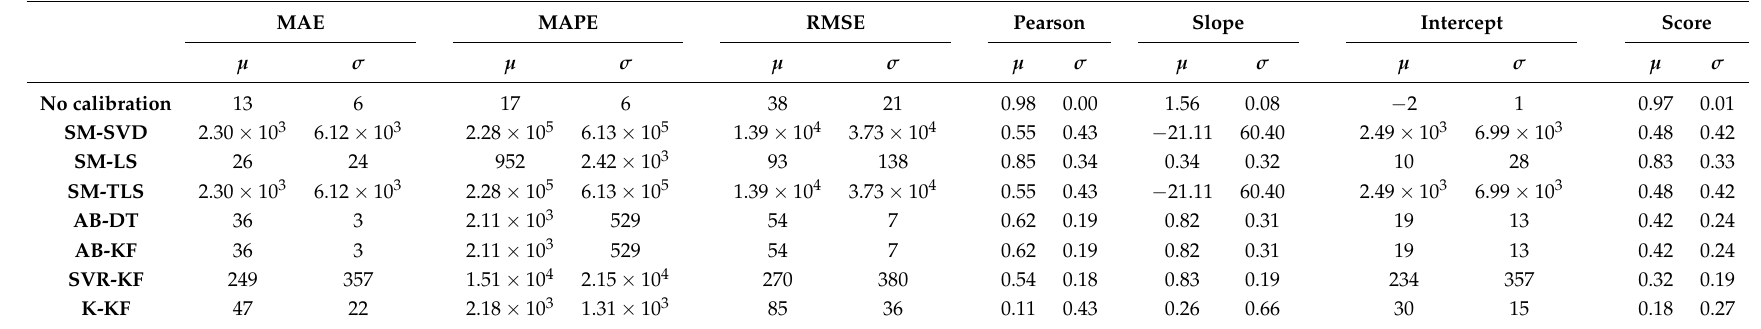
Table 7. Mean and standard deviation of each metric, computed on the entire time interval of drift, over the 16 nodes of the network with the Gaussian plume model. No calibration strategy allows to obtain less error than without calibration, even for SM-(SVD, LS, TLS) strategies that had the best performances in Section 4.